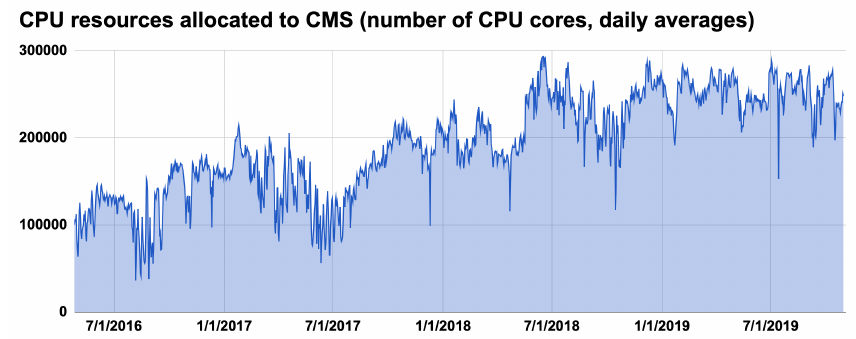
Figure 1. Global Pool size in number of CPU cores averaged daily over the last 3